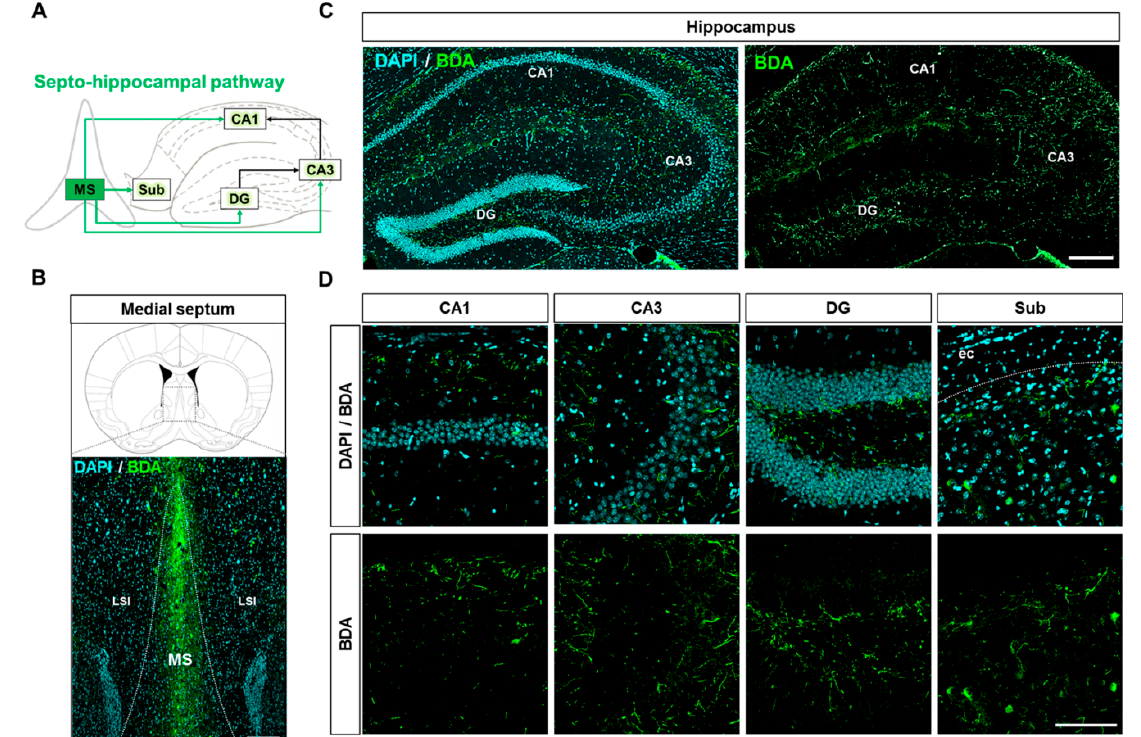
Figure 6. Profiling of the septo-hippocampal pathway with the anterograde neuronal tracer BDA. ( A ) Schematic of septo-hippocampal pathway. Green arrows indicate the e ff erent projections from the MS to the hippocampal formation. Black arrows indicate the indirect e ff erent projections from the MS to the hippocampal formation. ( B ) Verification of the MS coordinates by stereotaxic injection of the anterograde tracer BDA. Scale bar = 200 µ m. ( C ) Visualization of BDA anterogradely transported from the MS to the hippocampus. Scale bar = 200 µ m. ( D ) Magnified images represent BDA-labeled axon terminals in the subregions of the hippocampal formation. DAPI was used to counterstain the nuclei. Scale bar = 50 µ m.